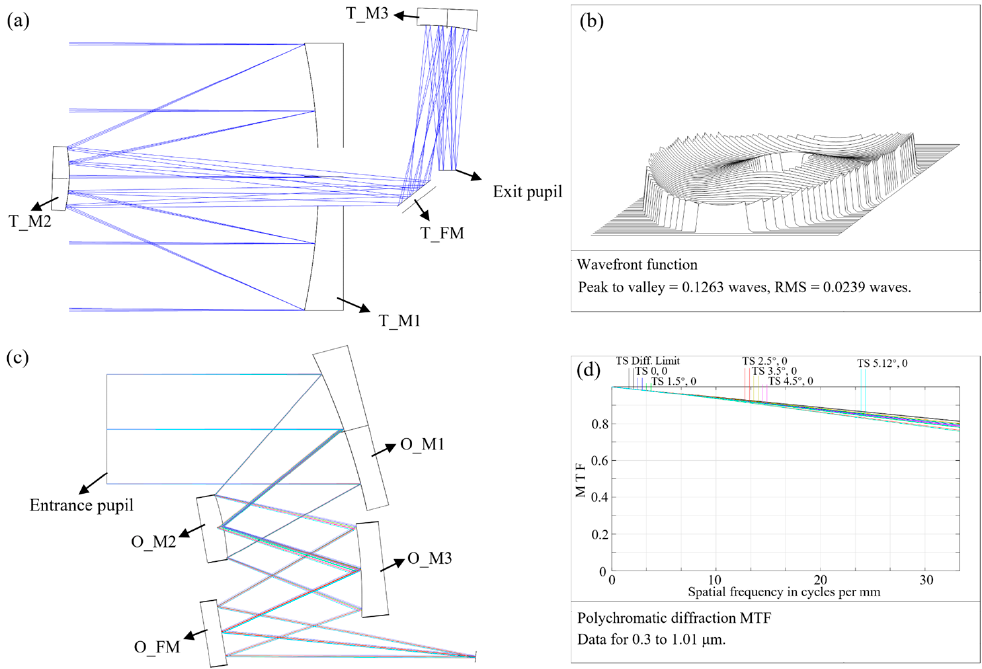
Figure 3. ( a ) Optical path of the afocal telescope and ( b ) its wavefront map. ( c ) Optical path of objective Ⅰ and its ( d ) MTF curves.